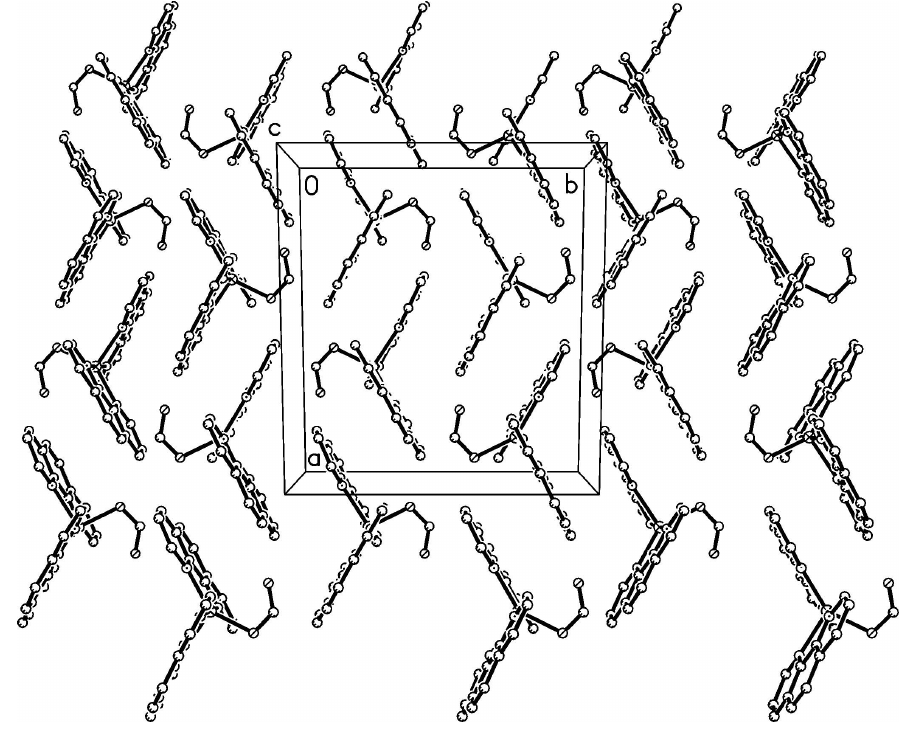
Figure 2 Supramolecular assembly of the [Cu(phen)